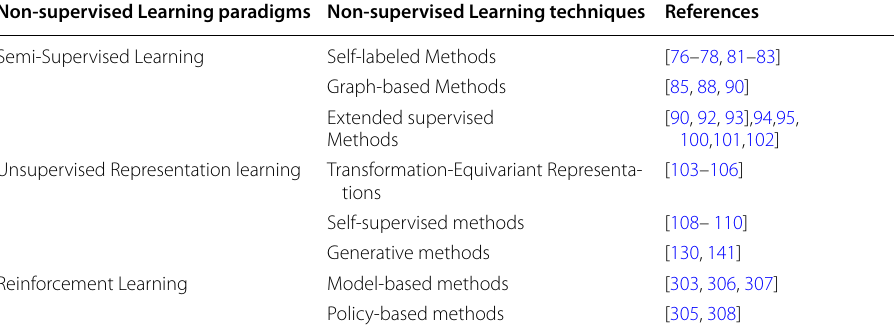
Table 1 Summary of non-supervised learning methods Non‑supervised Learning paradigms Non‑supervised Learning techniques References Semi-Supervised